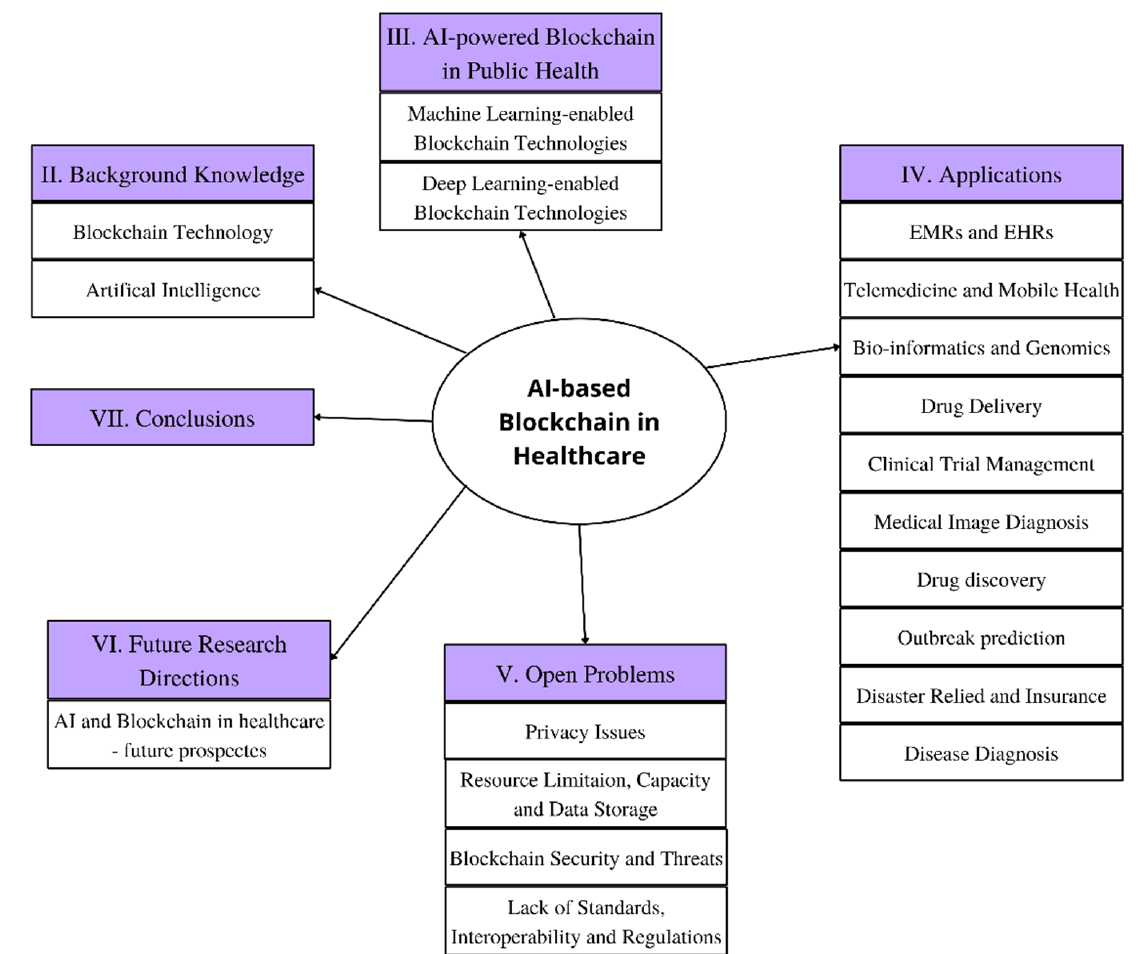
Figure 5. Block diagram representing the structure of this review.